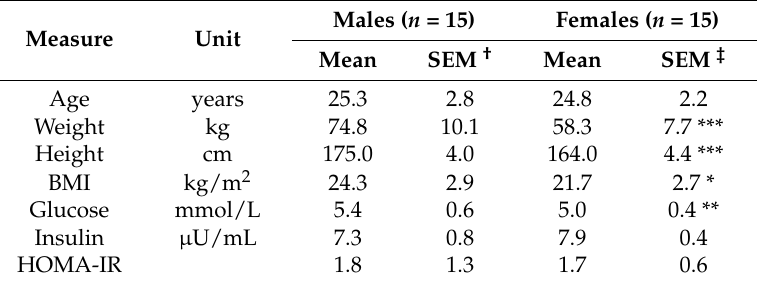
Table 3. Baseline subject